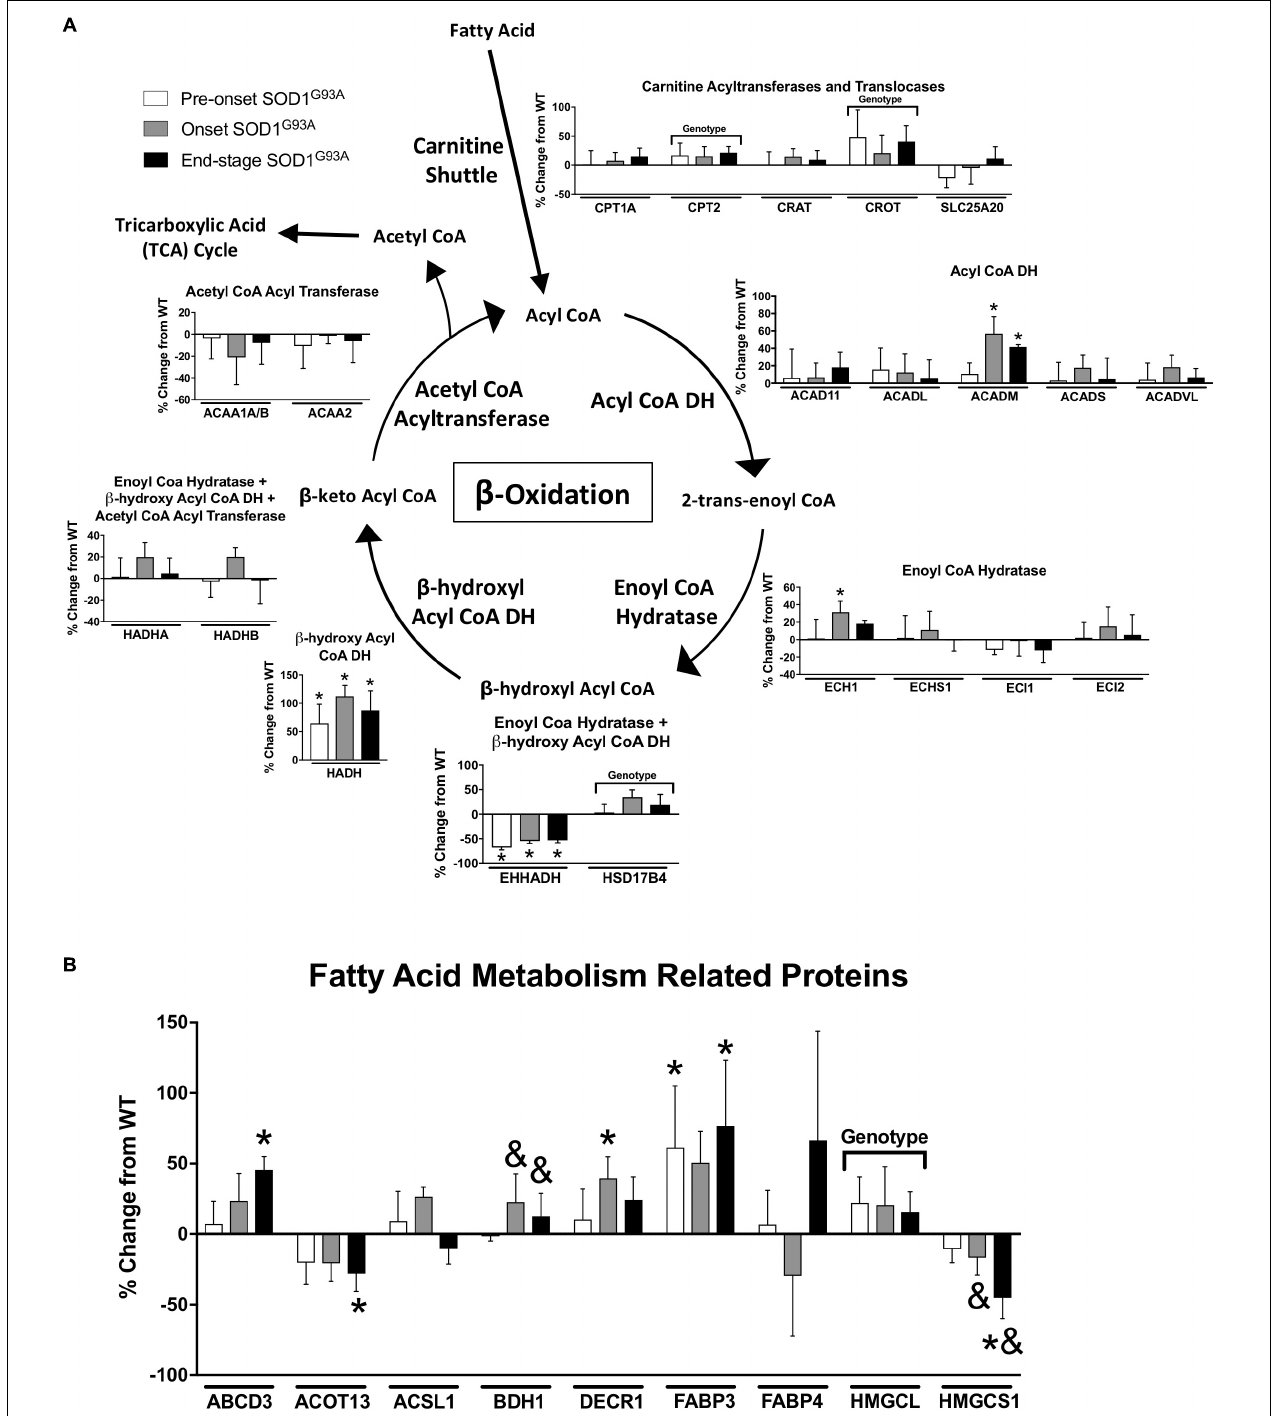
FIGURE 3 | Fatty acid metabolism. Changes in protein content of fatty acid metabolism in SOD1 G93A spinal cords compared to controls measured by mass spectrometry ( n = 5–6). (A) β -oxidation. (B) Fatty acid metabolism related proteins. Data are represented as percent change relative to the same time point wild-type control. Bars represent means ± standard deviation. “Genotype” denotes a significant genotype effect in Benjamini-Hochberg corrected two-way ANOVA with p < 0.05 but no individual Multiple Comparison test was significant. Significance symbols demonstrate p < 0.05 for a genotype effect and additional significant results for the Tukey Multiple Comparison test. ∗ p < 0.05 wild-type vs. SOD1 G93A at the designated time point; & p < 0.05 vs. SOD1 G93A pre-onset. SOD1 G93A pre-onset (white), SOD1 G93A onset (gray), SOD1 G93A end-stage (black). DH, dehydrogenase; CoA, coenzyme A. Protein names, IDs, and absolute expression values are detailed in Supplemental Table 1